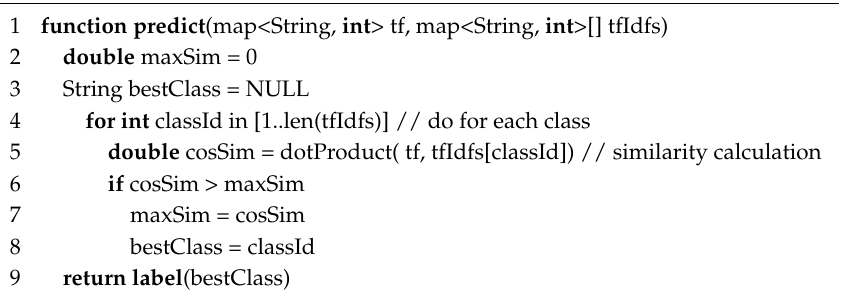
Algorithm 2. Classification using 1-NN and MBOSS-VS models.